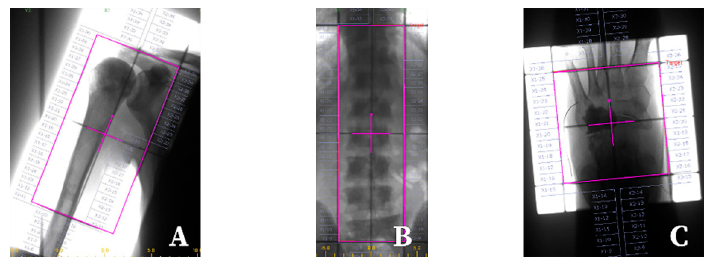
Figure 1. Simulation fields (pink rectangle) for irradiation of painful bone metastases with megavoltage photon external beams: ( A ) humeral bone, ( B ) spine, ( C ) foot bones.